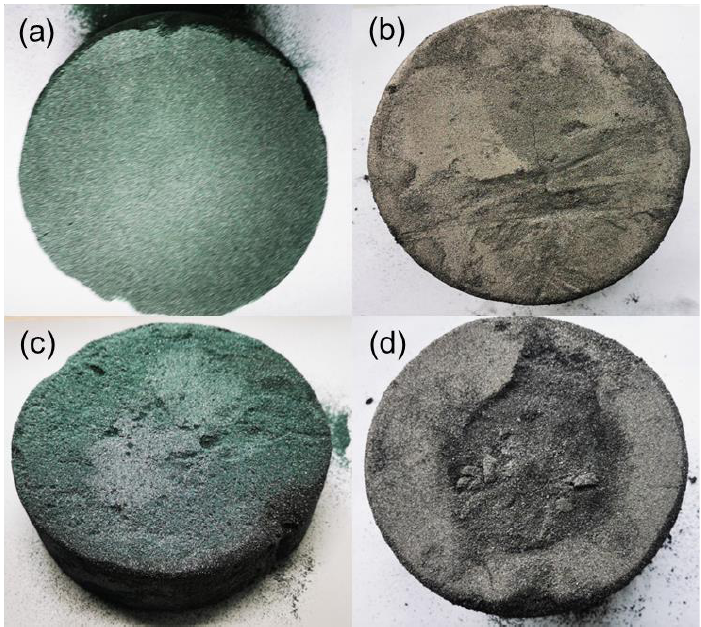
Figure 4. SiC powder after purification; ( a ) process A; ( b ) process B; ( c ) process C; ( d ) process